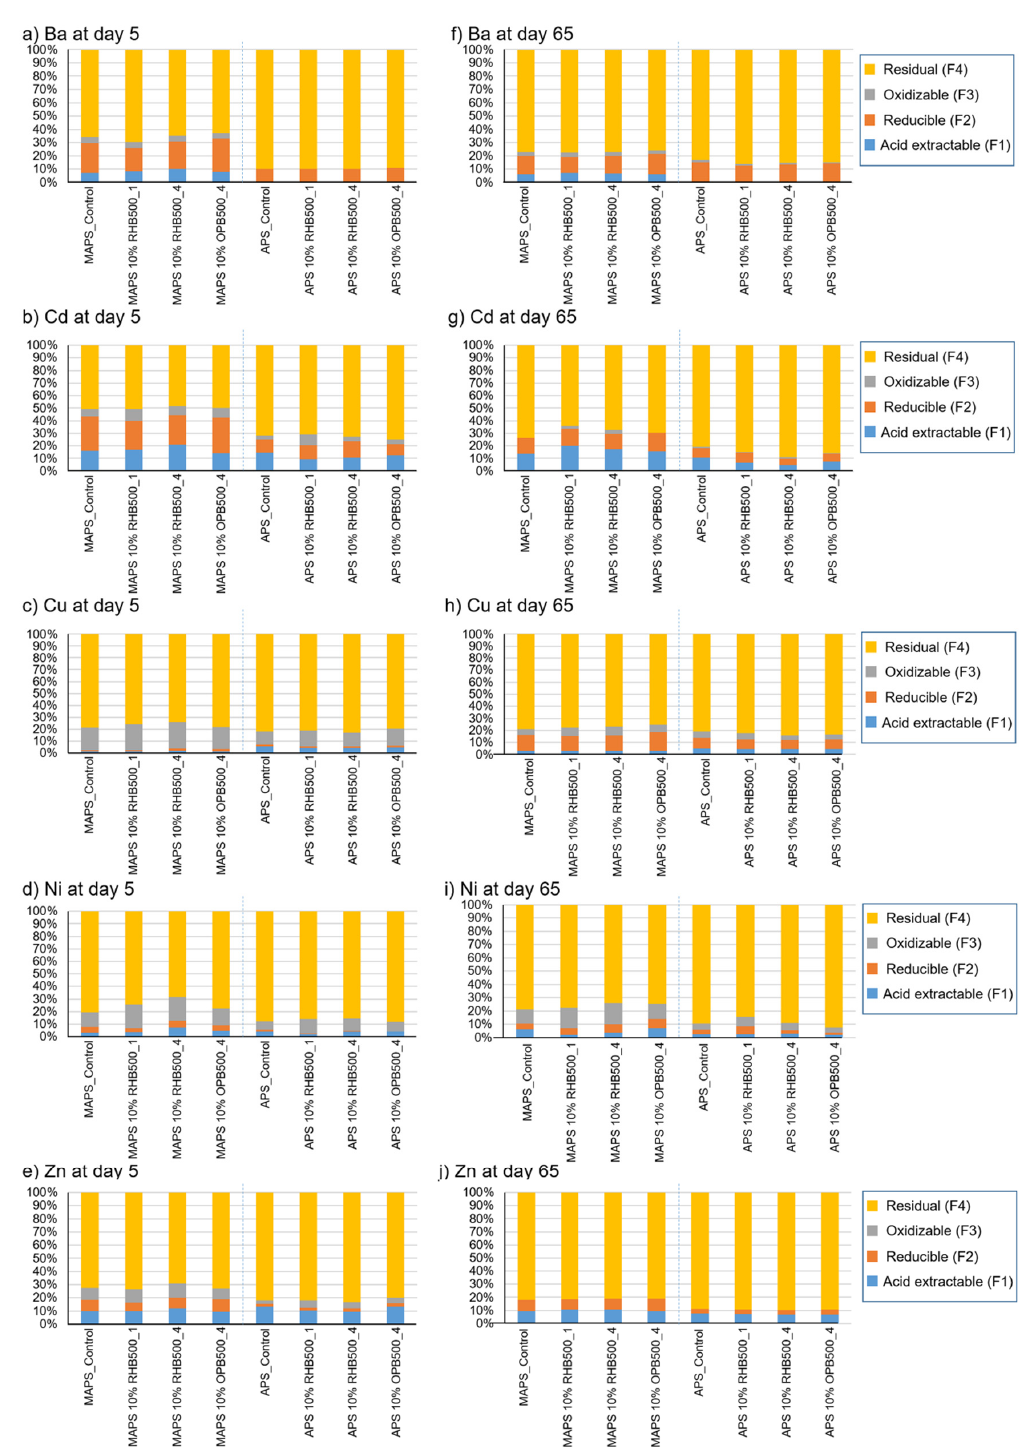
Figure 4. Fractions of heavy metals extracted from soils in each step of sequential extraction: ( a ) Ba after 5 days of incubation, ( b ) Cd after 5 days of incubation, ( c ) Cu after 5 days of incubation, ( d ) Ni after 5 days of incubation, ( e ) Zn after 5 days of incubation, ( f ) Ba after 65 days of incubation, ( g ) Cd after 65 days of incubation, ( h ) Cu after 65 days of incubation, ( i ) Ni after 65 days of incubation and ( j ) Zn after 65 days of incubation.